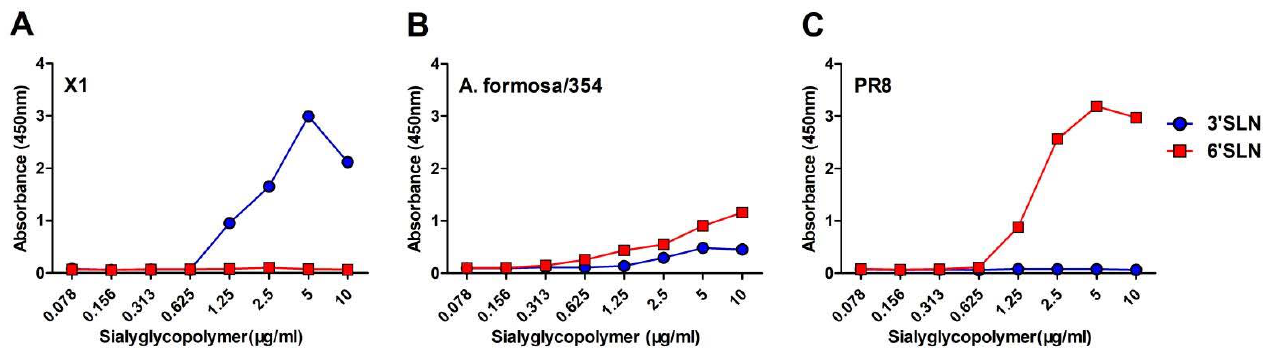
Figure 6. Receptor-binding properties of the H12 isolate. ( B ) The binding of the H12 isolate with sialic acid was determined using various concentrations of sialic acid conjugated to biotinylated sialylglycopolymers (3 ′ SLN and 6 ′ SLN) via direct solid ‐ phase binding assays. ( A ) X1 and ( C ) PR8